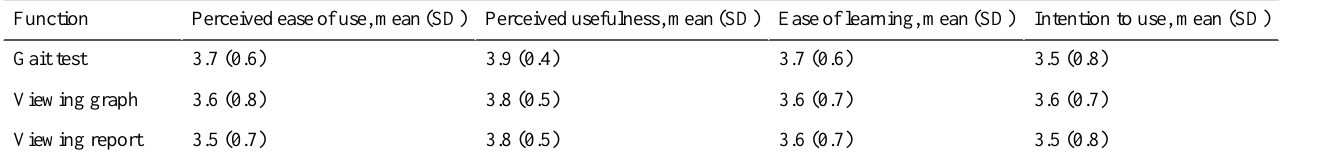
Table 7. Descriptive statistics for the acceptability of the